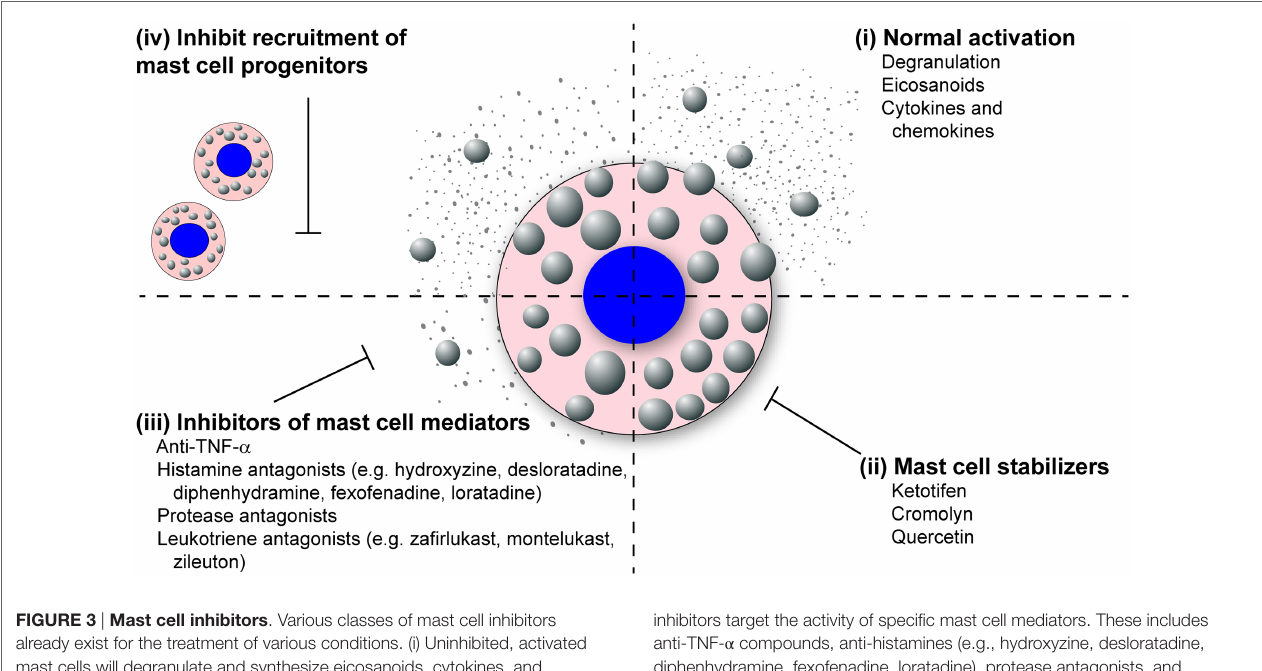
FiguRe 3 | Mast cell inhibitors . Various classes of mast cell inhibitors already exist for the treatment of various conditions. (i) Uninhibited, activated mast cells will degranulate and synthesize eicosanoids, cytokines, and chemokines which are released into the surrounding tissue. (ii) The mast cell stabilizing drugs (e.g., ketotifen, cromolyn, and quercetin) block the release of mast cell granules following activation. (iii) Second broad class of mast cell